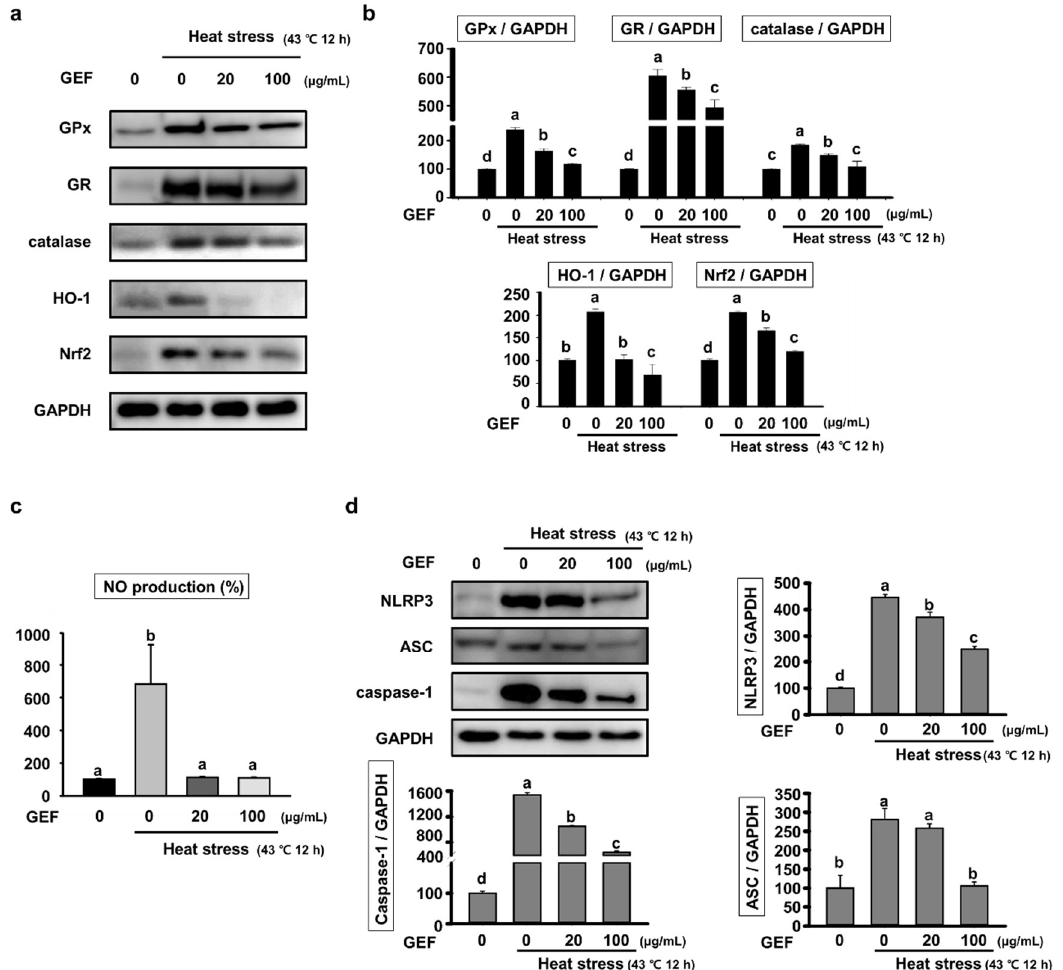
Figure 2. Expression of oxidative stress–related proteins and NLRP3 inflammasome in C2C12 cells under heat-exposed conditions; ( a ) analysis of glutathione peroxidase (GPx), glutathione reductase (GR), catalase, HO-1 and Nuclear factor erythroid-2-related factor 2 (Nrf2) expression by western blot; ( b ) the density of GPx, GR, catalase, HO-1 and Nrf2 versus glyceraldehyde 3-phosphate dehydrogenase (GAPDH) was quantified and expressed as a bar graph, respectively; ( c ) the level of NO in the culture media in C2C12 cells pretreated with GEF (0, 20, 100 μg/mL) for 4 h and heat stress for 12 h was estimated using Griess reagent; ( d ) Expression of proteins related to inflammation, including NLRP3, Apoptosis-associated speck-like protein containing a CARD (ASC) and caspase-1 analyzed by Western blot. The density of NLRP3, ASC and caspase-1 versus GAPDH was quantified and expressed as a bar graph, respectively. Values labeled with different letters are significantly different ( p < 0.05).